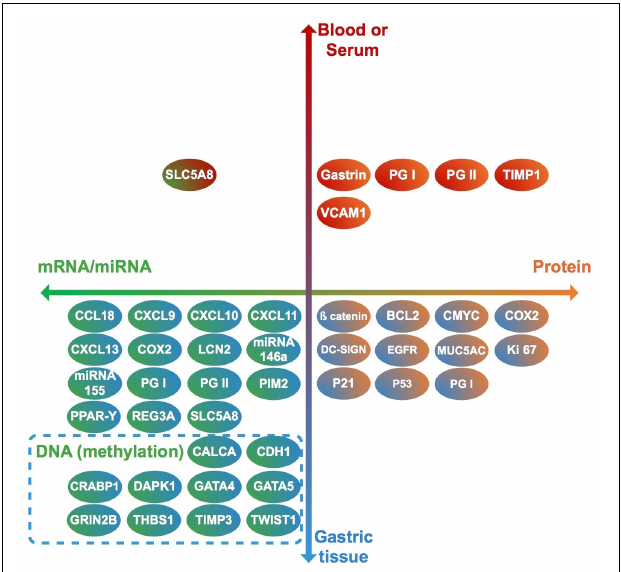
FIGURE 2 | Clinical samples used to analyze each biomarker (vertical axis), and molecules identified in each case (horizontal axis). Each biomarker identified in this review is represented by a circle. Upper half: biomarkers analyzed in blood or serum. Lower half: biomarkers analyzed in gastric tissue. Right half: Biomarkers identified as proteins. Left half: biomarkers identified as RNA or DNA. Genes (DNA) in which methylation levels were analyzed are surrounded by a dashed